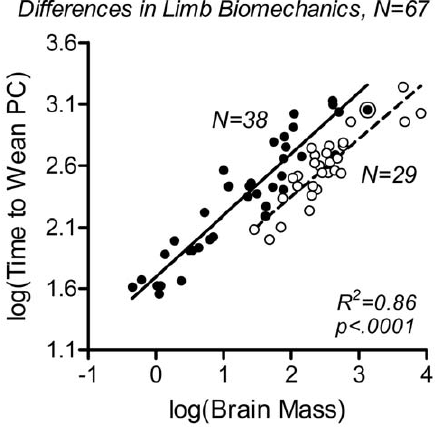
Figure 3. Limb biomechanics is a predictor of time to weaning. Time to weaning was plotted as a function of the continuous variable adult brain mass, log (Brain Mass), and the grouping variable ‘limb biomechanics’ (see main text and Materials and methods for definition; Table S1). Filled symbols and solid regression line represent species that can assume a plantigrade standing of the hindlimb (N=38); open symbols and dashed regression line represent ‘non-plantigrade’ species, in the present sample including digitigrade and unguligrade species and those that have either rudimentary or completely lack external hindlimbs (N=29). Double circle: humans. The grade shift between the two groups was highly significant. R 2 - and p-values for the multiple regression model are given in the diagram. The difference between this R 2 -value and the R 2 -value in Fig. 2 corresponds to the additional amount of variance accounted for by the grouping variable ‘limb biomechanics’.